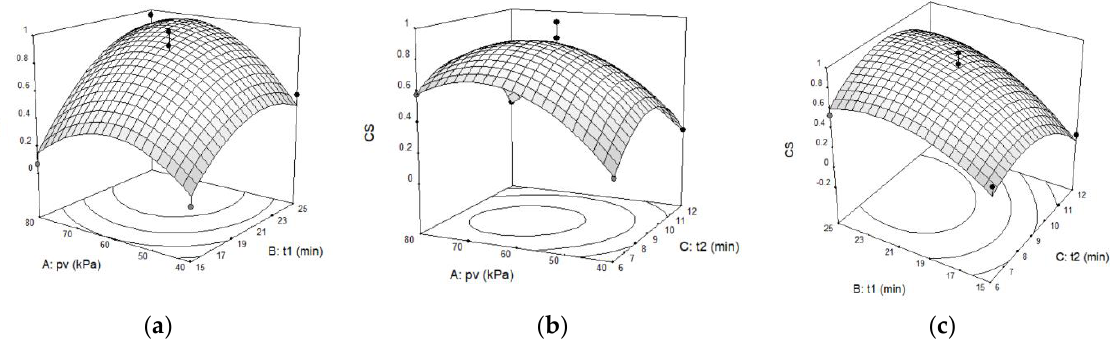
Figure 3. Three-dimensional response surface graphs for comprehensive score (CS) as a function of